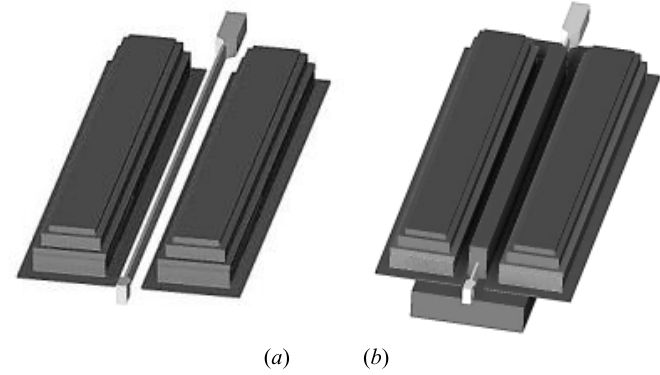
Fig. 3. 3D model of the transistor for OFF (a) and ON (b)